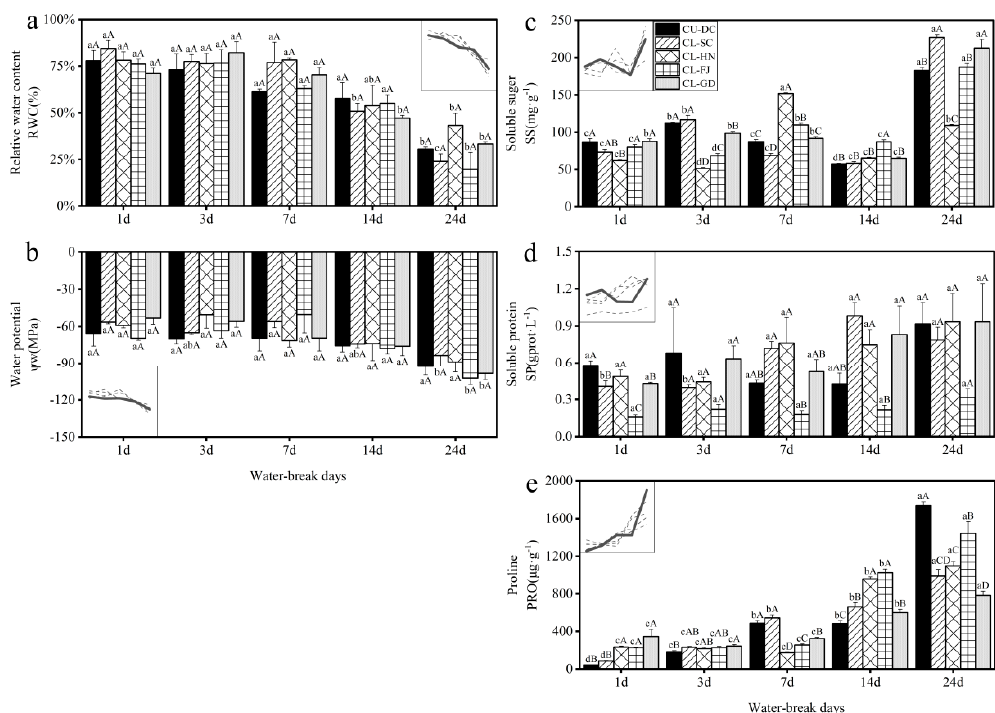
Figure 2. ( a ) relative water content ( RWC ), ( b ) water potential ( Ψ w ), ( c ) soluble sugar ( SS ), ( d ) soluble protein ( SP ) and ( e ) proline ( PRO ) of C. unica and C. lanceolata leaves under different water − break days. Solid line and dash lines in the small line chart within each subfigure represent C. unica and C. lanceolata , respectively; different lowercase letters indicate significant differences between different treatments for seedlings from the same provenance ( p < 0.05), and different uppercase letters indicate significant differences between different treatments for seedlings from different provenances ( p < 0.05); the same as below.